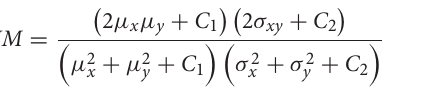
transformation with alpha of 255 × 3 and sigma of 255 × 0.10. We use TensorFlow 1.12.0 and Python framework to program, and train the proposed model on a TeslaV100-SXM2 GPU under a CentOS system environment. Two undersampling modes, including 1-dimensional Gaussian distribution and 2- dimensional Gaussian distribution, three sampling rates of 10, 20, and 30% (Corresponding to 10 × , 5 × , and 3.3 × acceleration factors respectively) were used for obtaining undersampling MRI. We train the model separately for each sampling mode. The sampling modes are shown in Figure 4 . The contrast experiments were carried out under the above